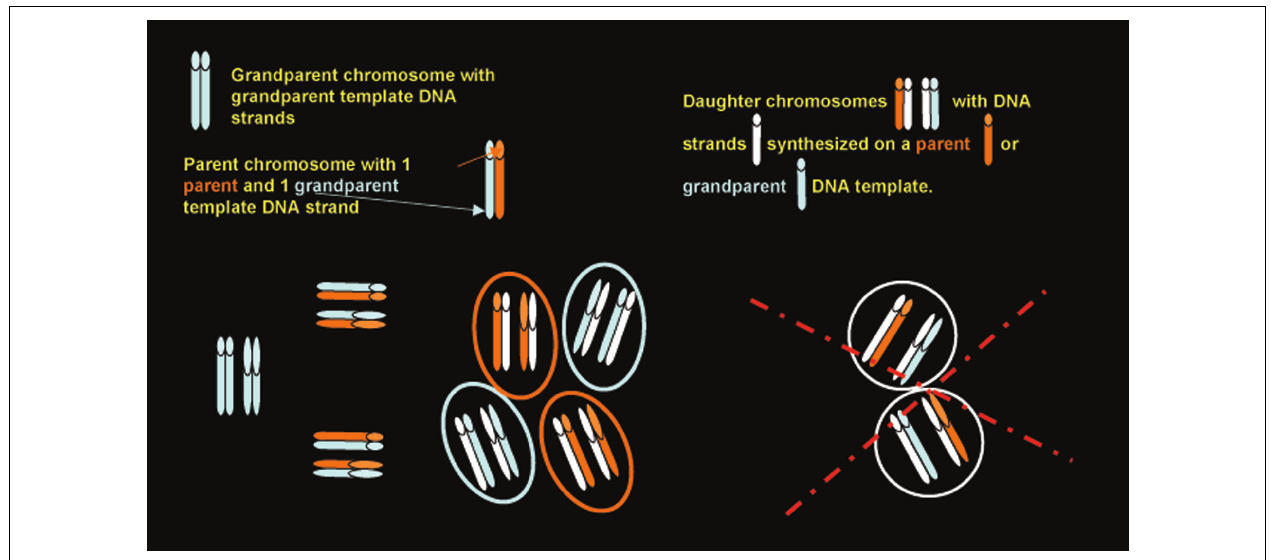
FIGURE 1 | Non-random segregation of chromosomes synthesized on DNA templates of different ages. Granddaughter cells (circled) contain chromosome sets synthesized either on grandparent DNA templates or on parent DNA template, but do not ( X ) receive sets that are mixtures of chromosomes synthesized some on grandparent- others on